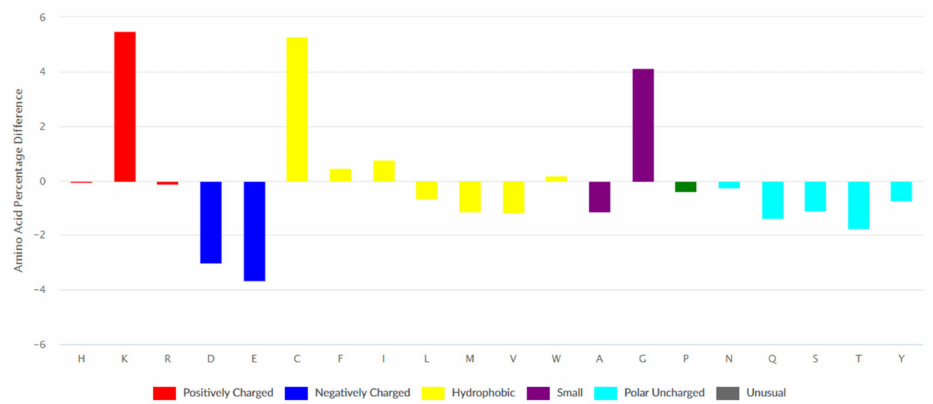
Figure 1. Amino acid composition of ribosomal peptides of DBAASP presenting as the difference from UniProt (https://dbaasp.org/statistics, accessed on 20 March